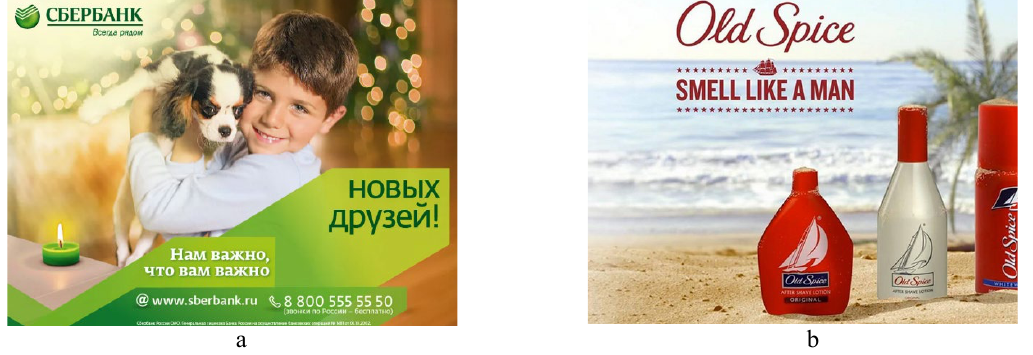
Figure 6 – Examples of image